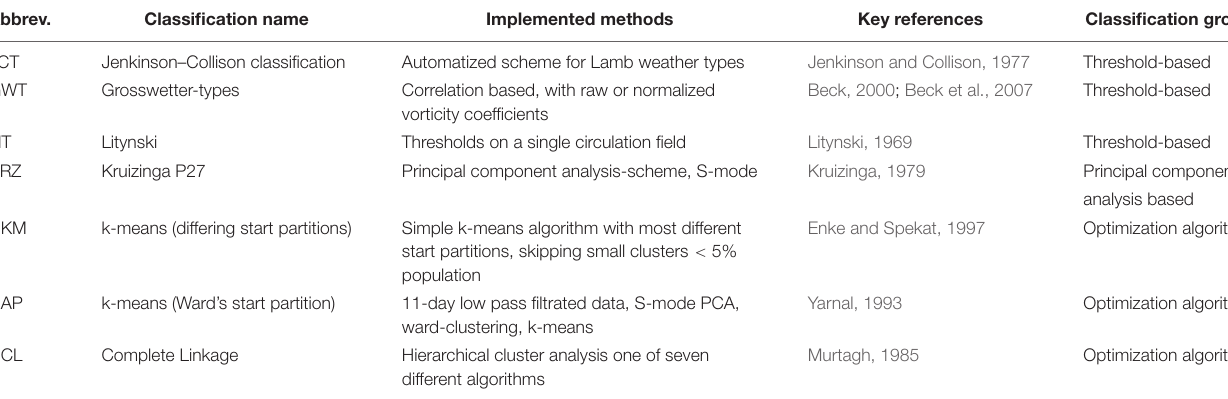
TABLE 1 | Classification methods applied in the present study, the list includes abbreviations used within this paper, commonly used names of the methods, the key references of methods and the methodological group.